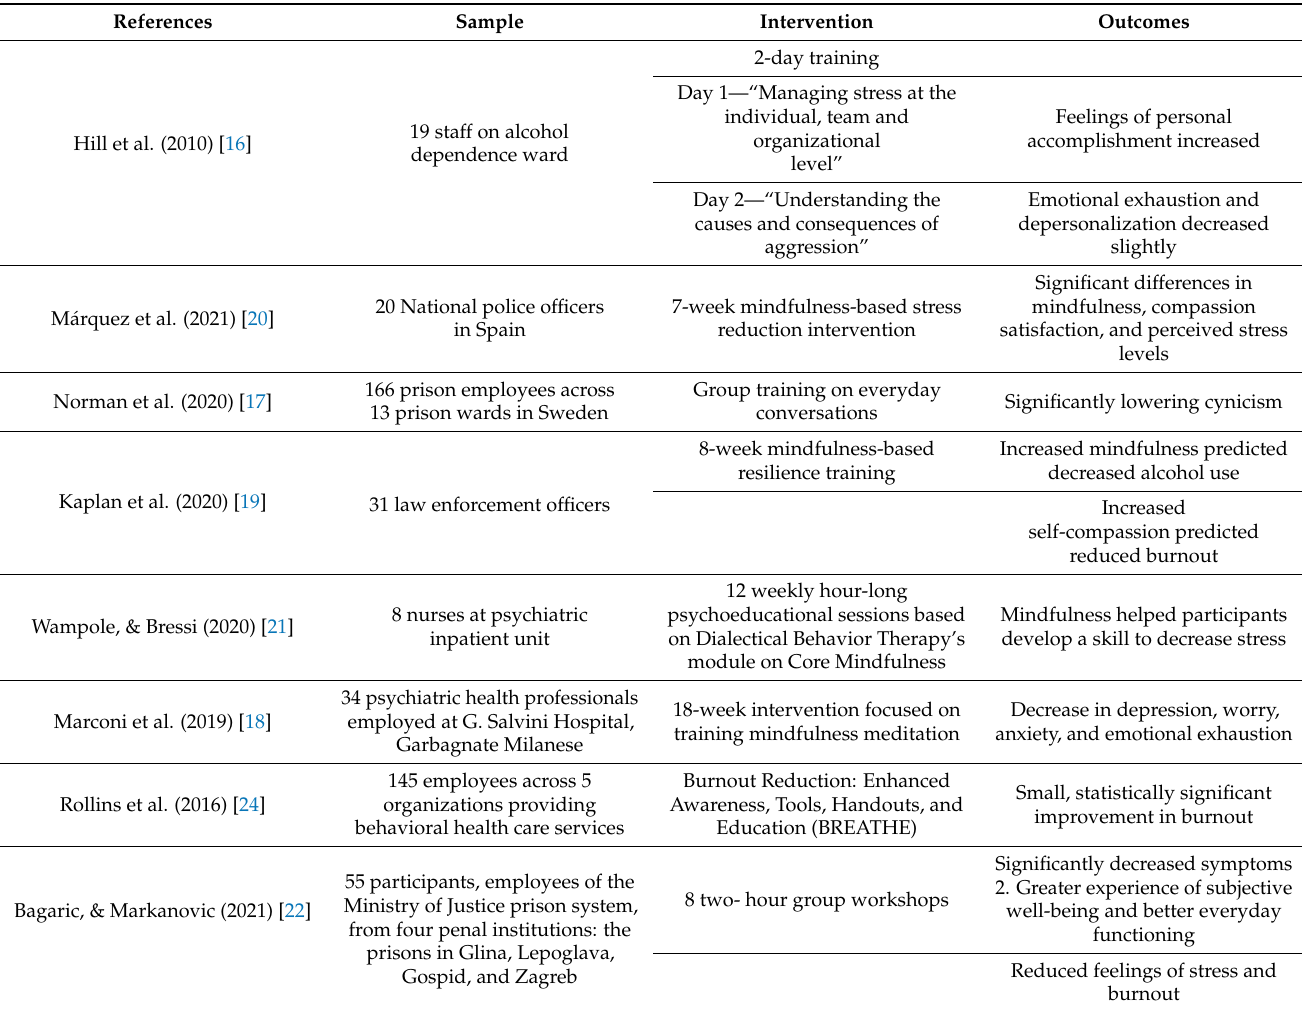
Table 6. Stage 2 Characteristics of included